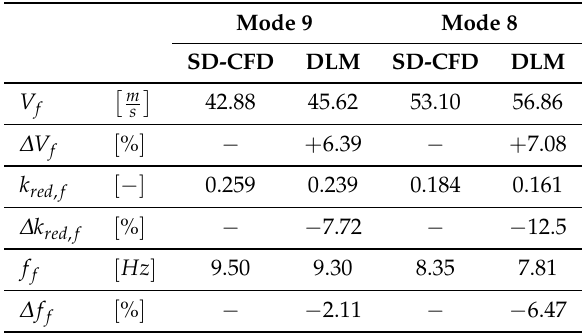
Table 3. Overview of the predicted flutter limits based on SD-CFD and DLM modeling.